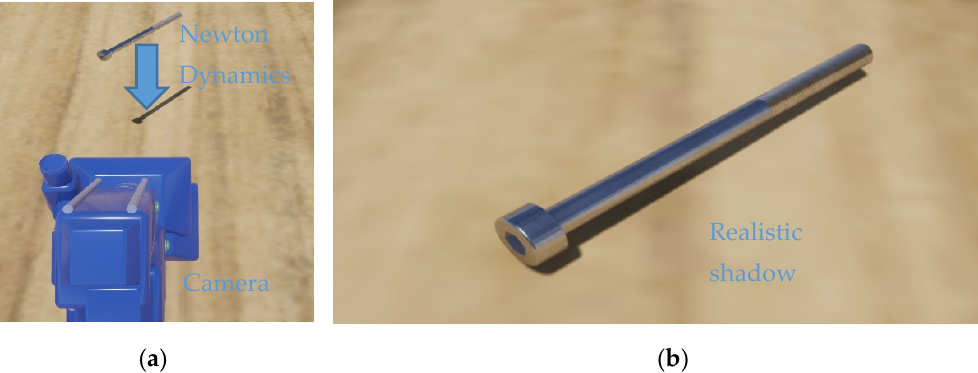
Figure 6. An example project in the Unreal Engine: ( a ) 3D virtual model of a screw in the Unreal Engine editor; ( b ) 3D after dynamic simulation with cinematics texture and shadow.